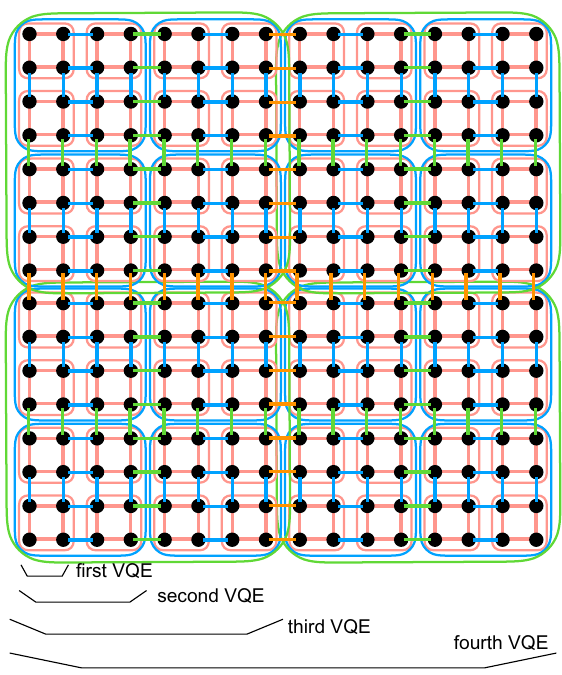
FIG. 2. Concatenation of VQEs. Red, blue, green squares cor- respond to the first, second, and third VQEs, respectively. The red, blue, green, and orange edges indicate the intersubsystem interactions taken at the first, second, third, and fourth VQEs. At each level, the local basis is generated by the local excitations on each qubit at the boundary, that is, the qubits engaged in the inter- subsystem interactions. At each level, the effective Hamiltonian is constructed from suitably chosen local